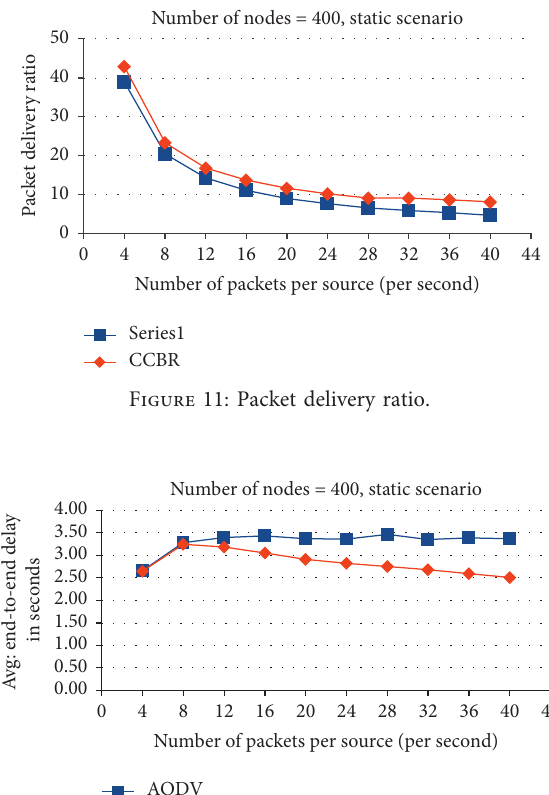
Figure 12: Average end-to-end delay.